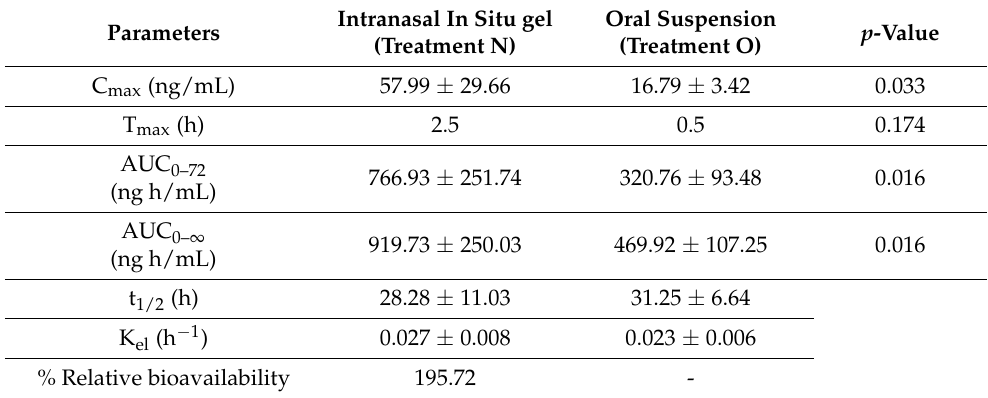
Table 6. Pharmacokinetic parameters of dronedarone following the administration of intranasal niosomal in situ gelling spray (treatment N) and oral suspension (treatment O) a,b